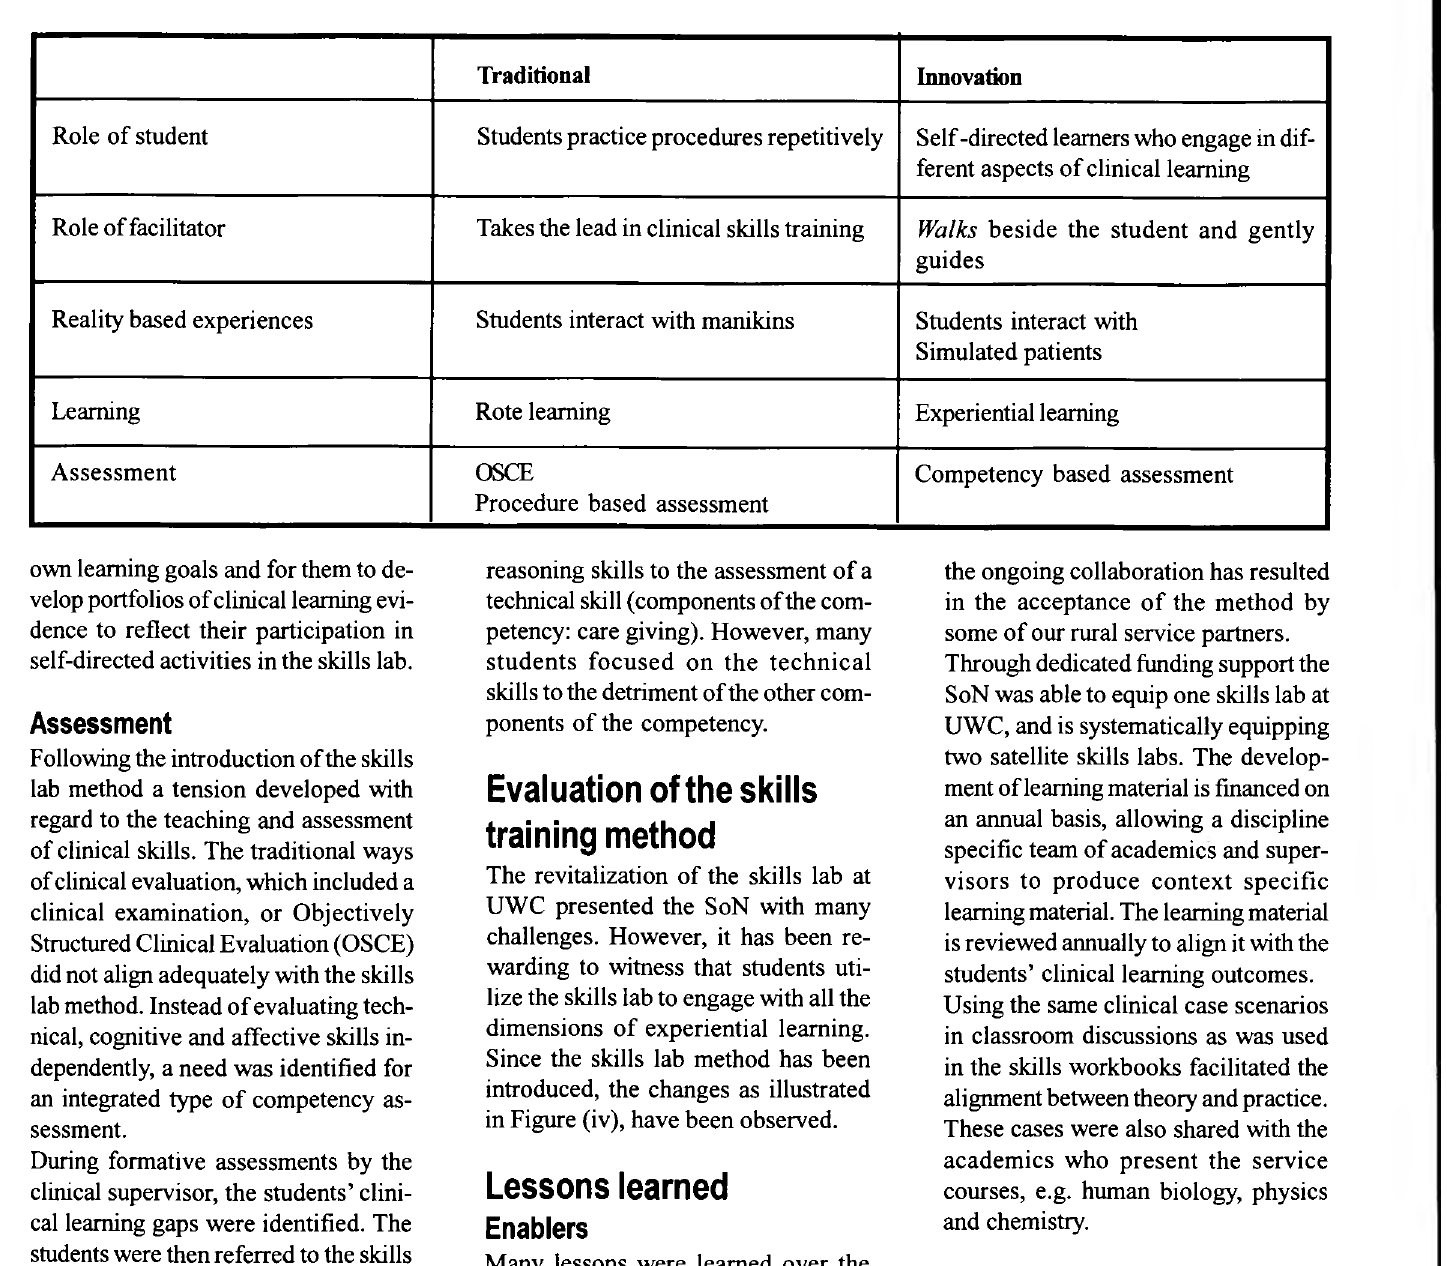
Figure (iv): Evaluation of the skills lab